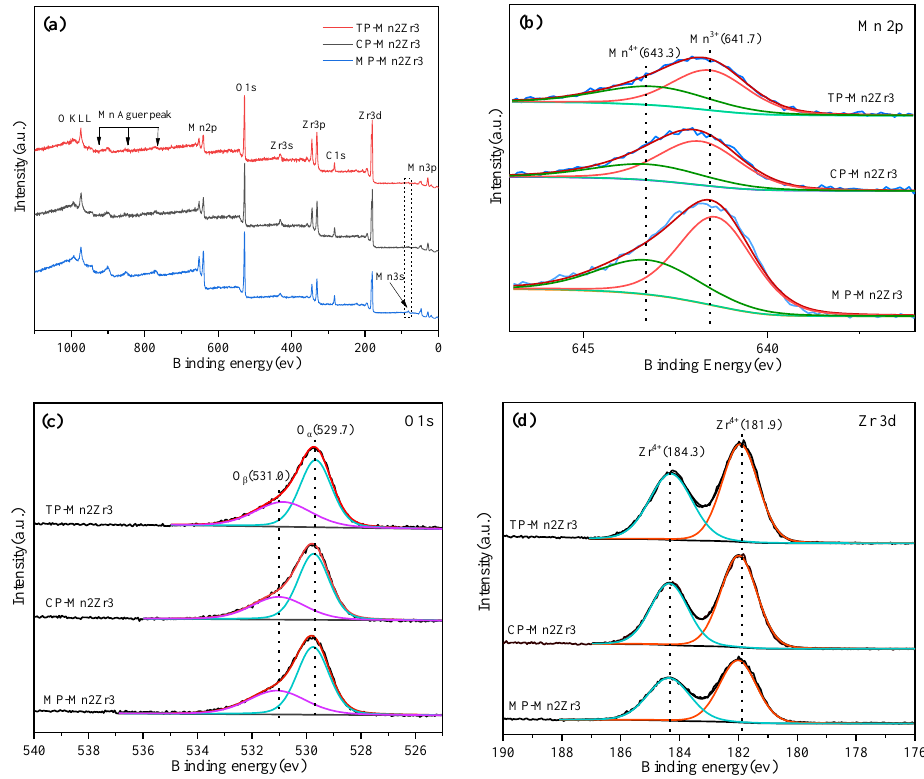
6 of 15 Figure 3. High resolution transmission electron microscope (HRTEM) images of CP-Mn2Zr3 ( a , b ) and TP-Mn2Zr3 ( c , d ).